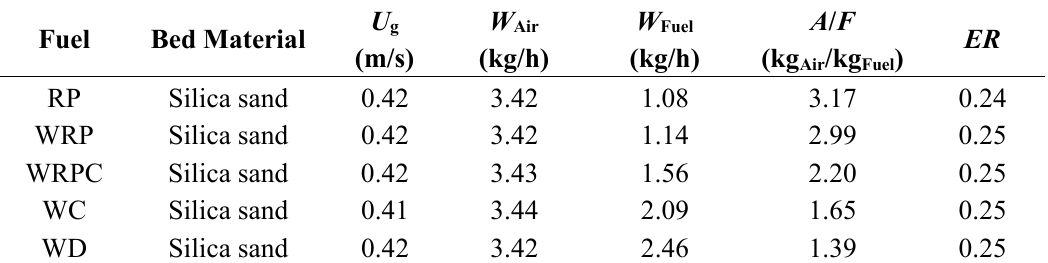
Table 1. Operating conditions of experimental